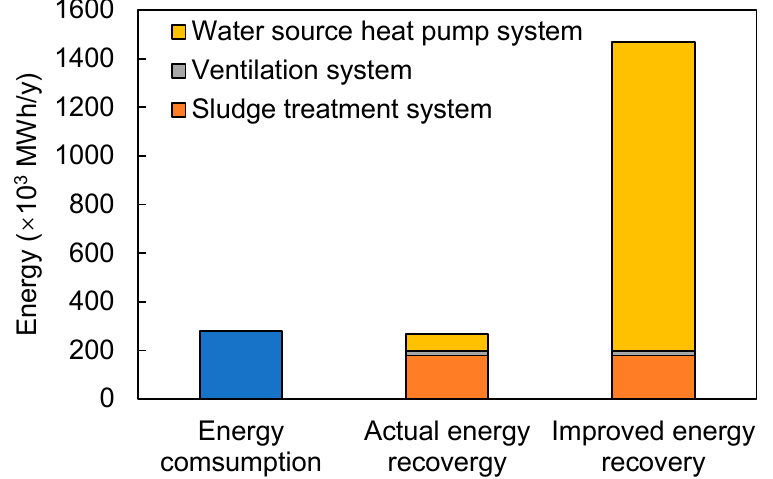
Figure 2. Annual energy consumption, actual energy recovery, and improved energy recovery after extracting heat from the secondary effluent in Gaobeidian WWTP. Table 4. Calculations of energy recovery in Gaobeidian WWTP.